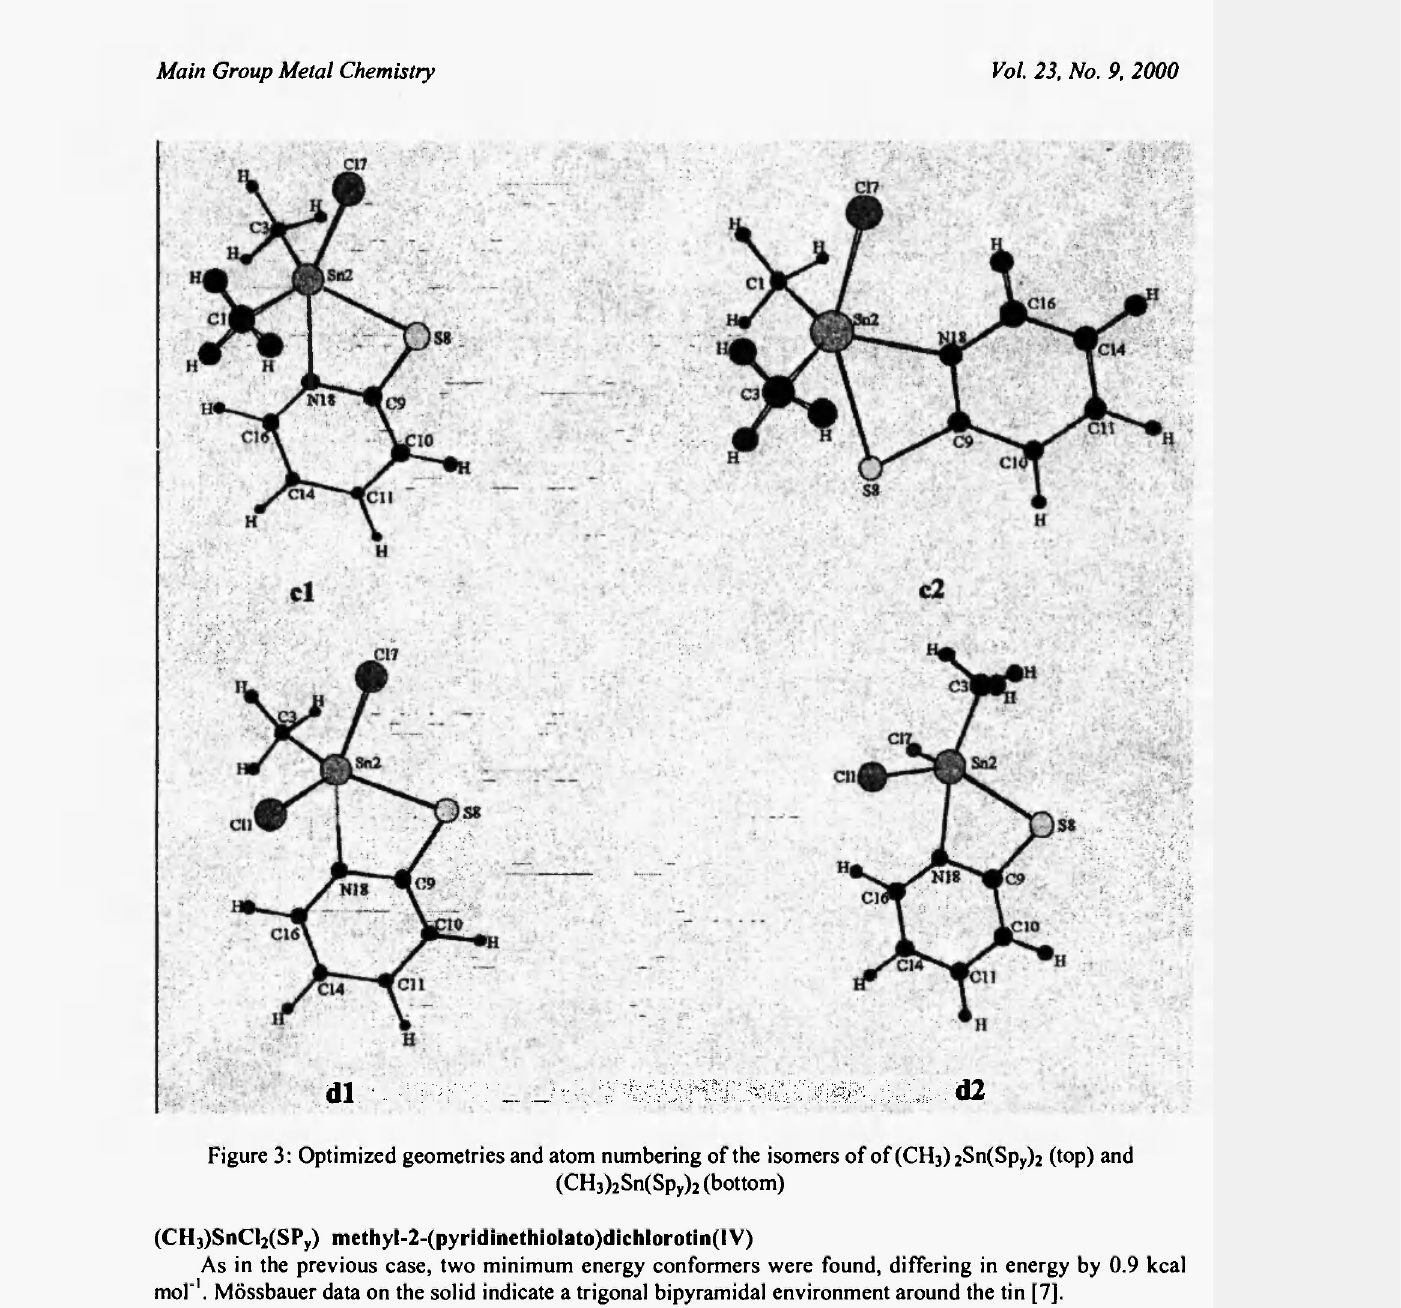
Figure 3: Optimized geometries and atom numbering of the isomers of of (CH3) 2 Sn(Sp y )2 (top) and (CH 3 ) 2 Sn(Spy)2 (bottom) (CH 3 )SnCl 2 (SP y )